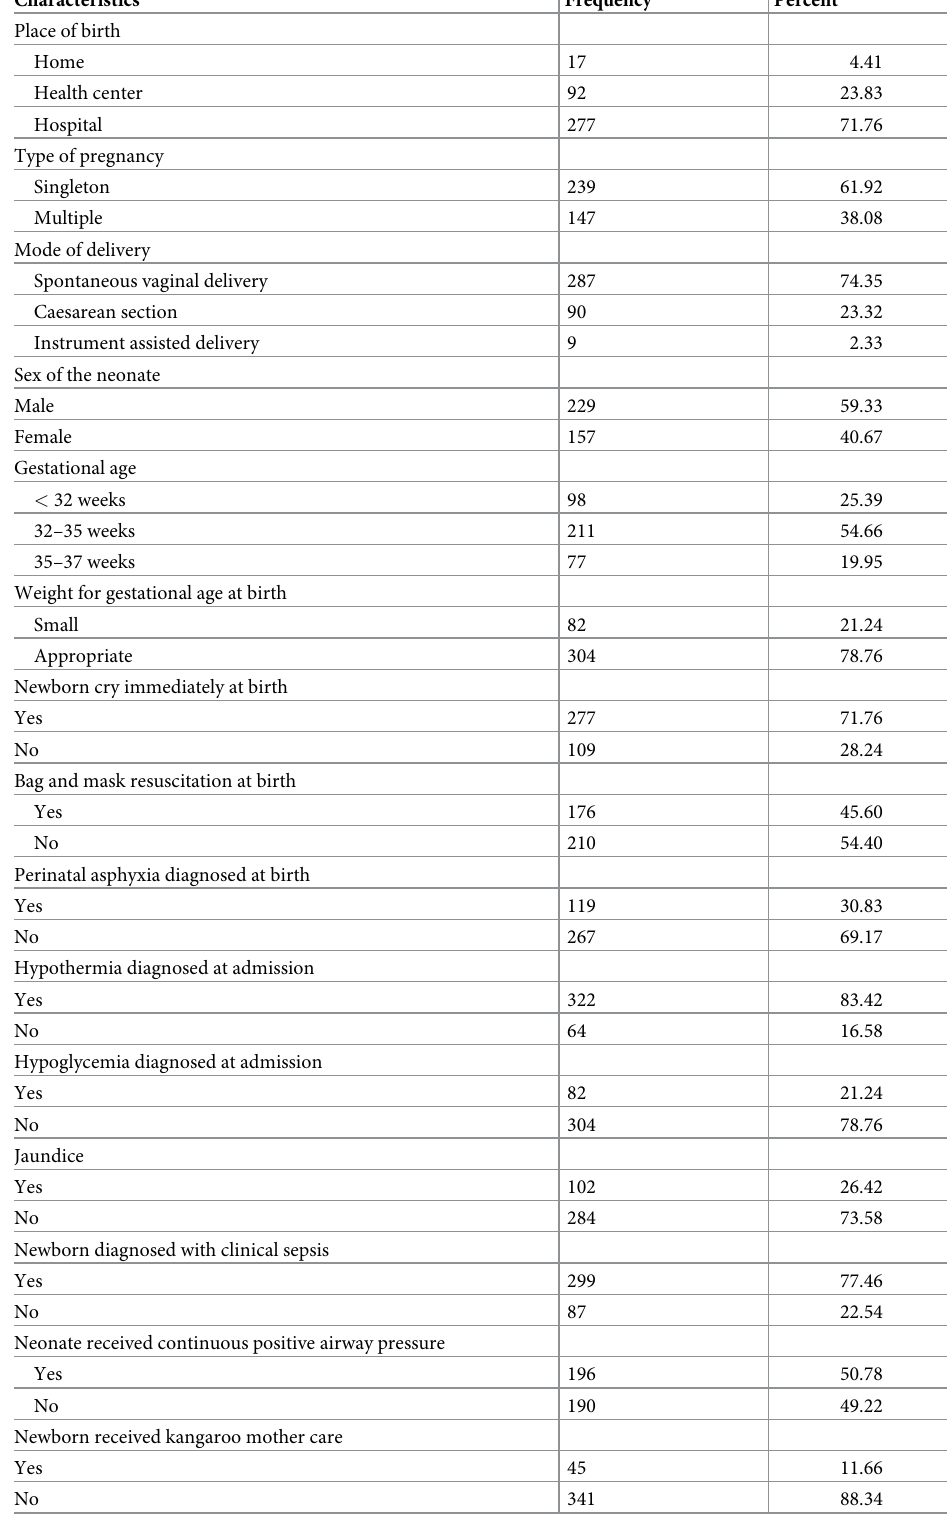
Table 1. Characteristics of preterm neonates admitted in NICU at University of Gondar comprehensive special- ized hospital with a diagnosis of RDS from January 2016 to December 2018 (n =